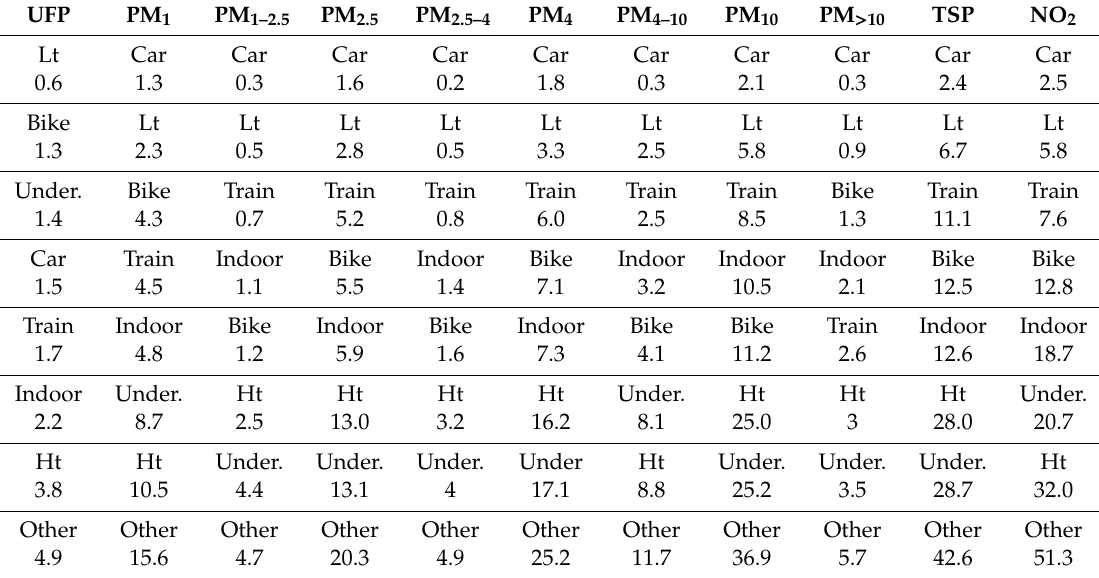
Table 4. Inhaled dose values ( µ g) reported from the lowest to the highest for di ff erent pollutants. Under.: Underground; lt: Walking lt; ht: Walking